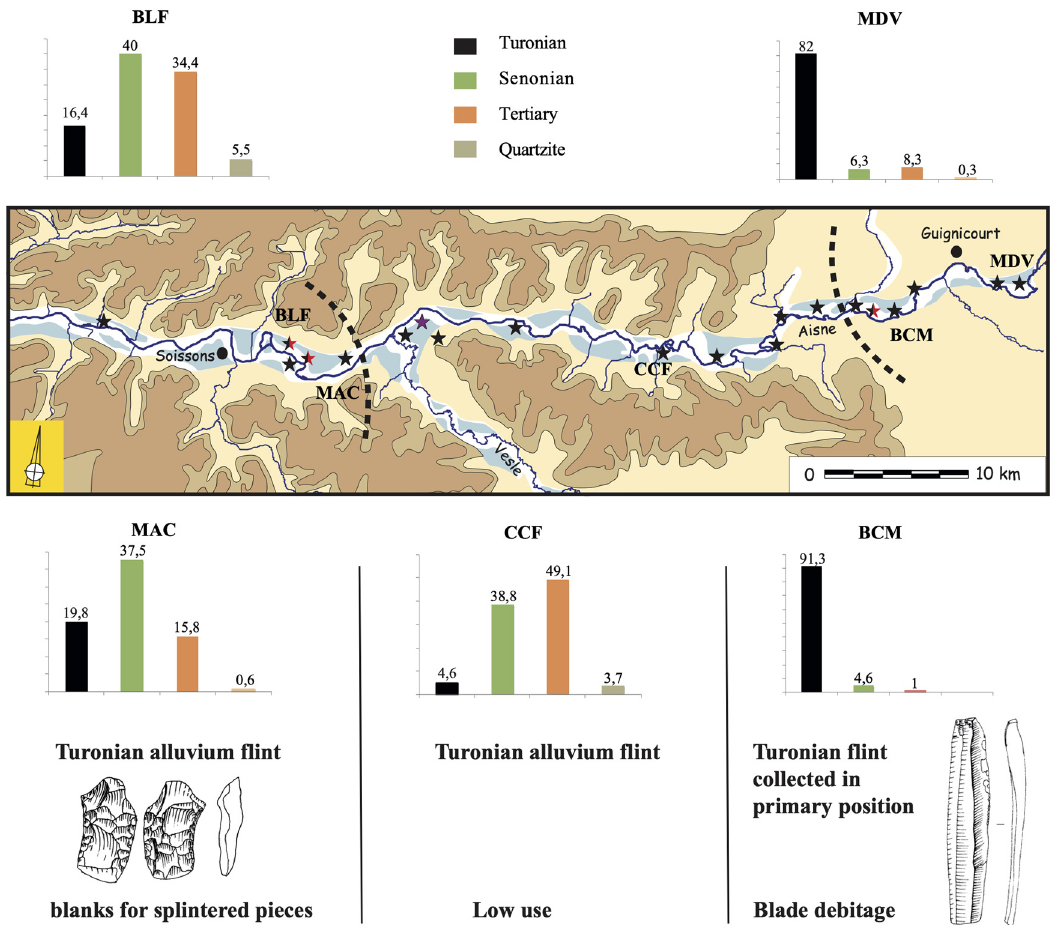
Figure 7: Frequency of the main fl ints in LBK assemblages ( fi ve sites are presented ) . The exploitation of Turonian fl int allows three distinct areas to be identi fi ed: a western area characterized by marked use of alluvial blocks, a central area characterized by low use, and an eastern area where this fl int was almost the only type used and collected from primary locations for blade